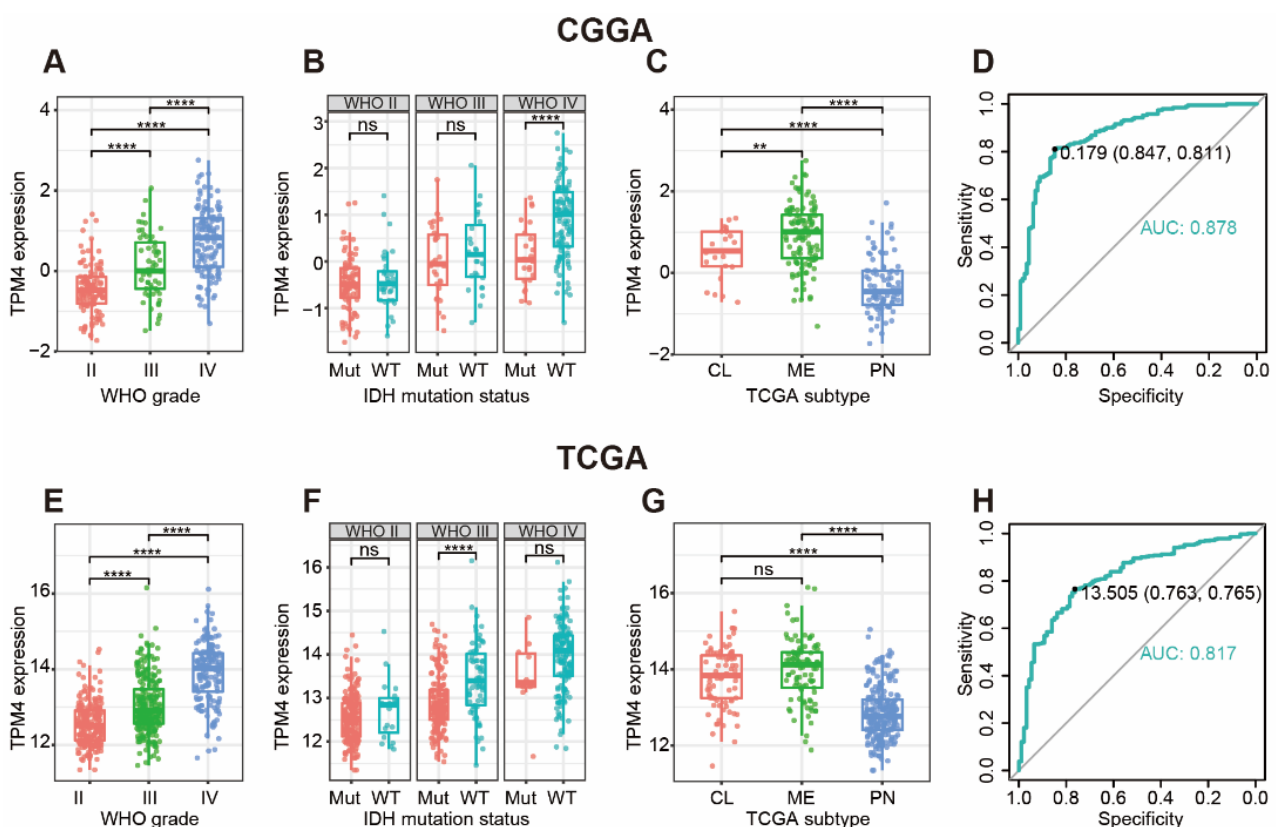
Figure 1. TPM4 expression according to WHO grade ( A , E ), IDH mutation status ( B , F ), TCGA molecular subtype ( C , G ), and receiver-operating characteristic (ROC) curves ( D , H ) for differentiating mesenchymal subtype. ** indicates p value < 0.01, **** indicates p value < 0.0001. ns: not significant; Mut: IDH mutation; WT: IDH wildtype; CL: classical subtype; ME: mesenchymal subtype; PN: proneural subtype; AUC: area under ROC